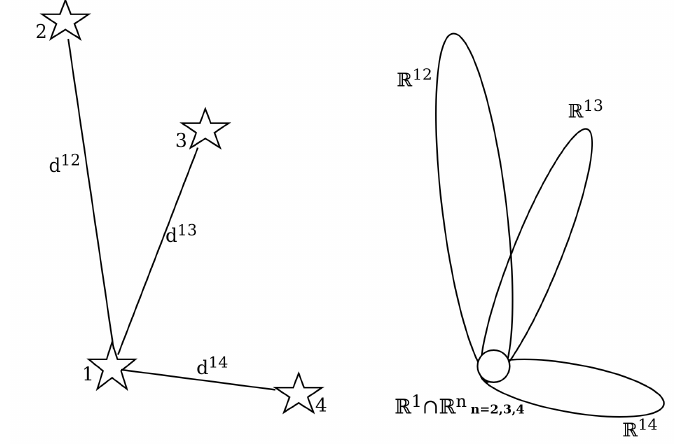
Figure 7. Group match algorithm principle.